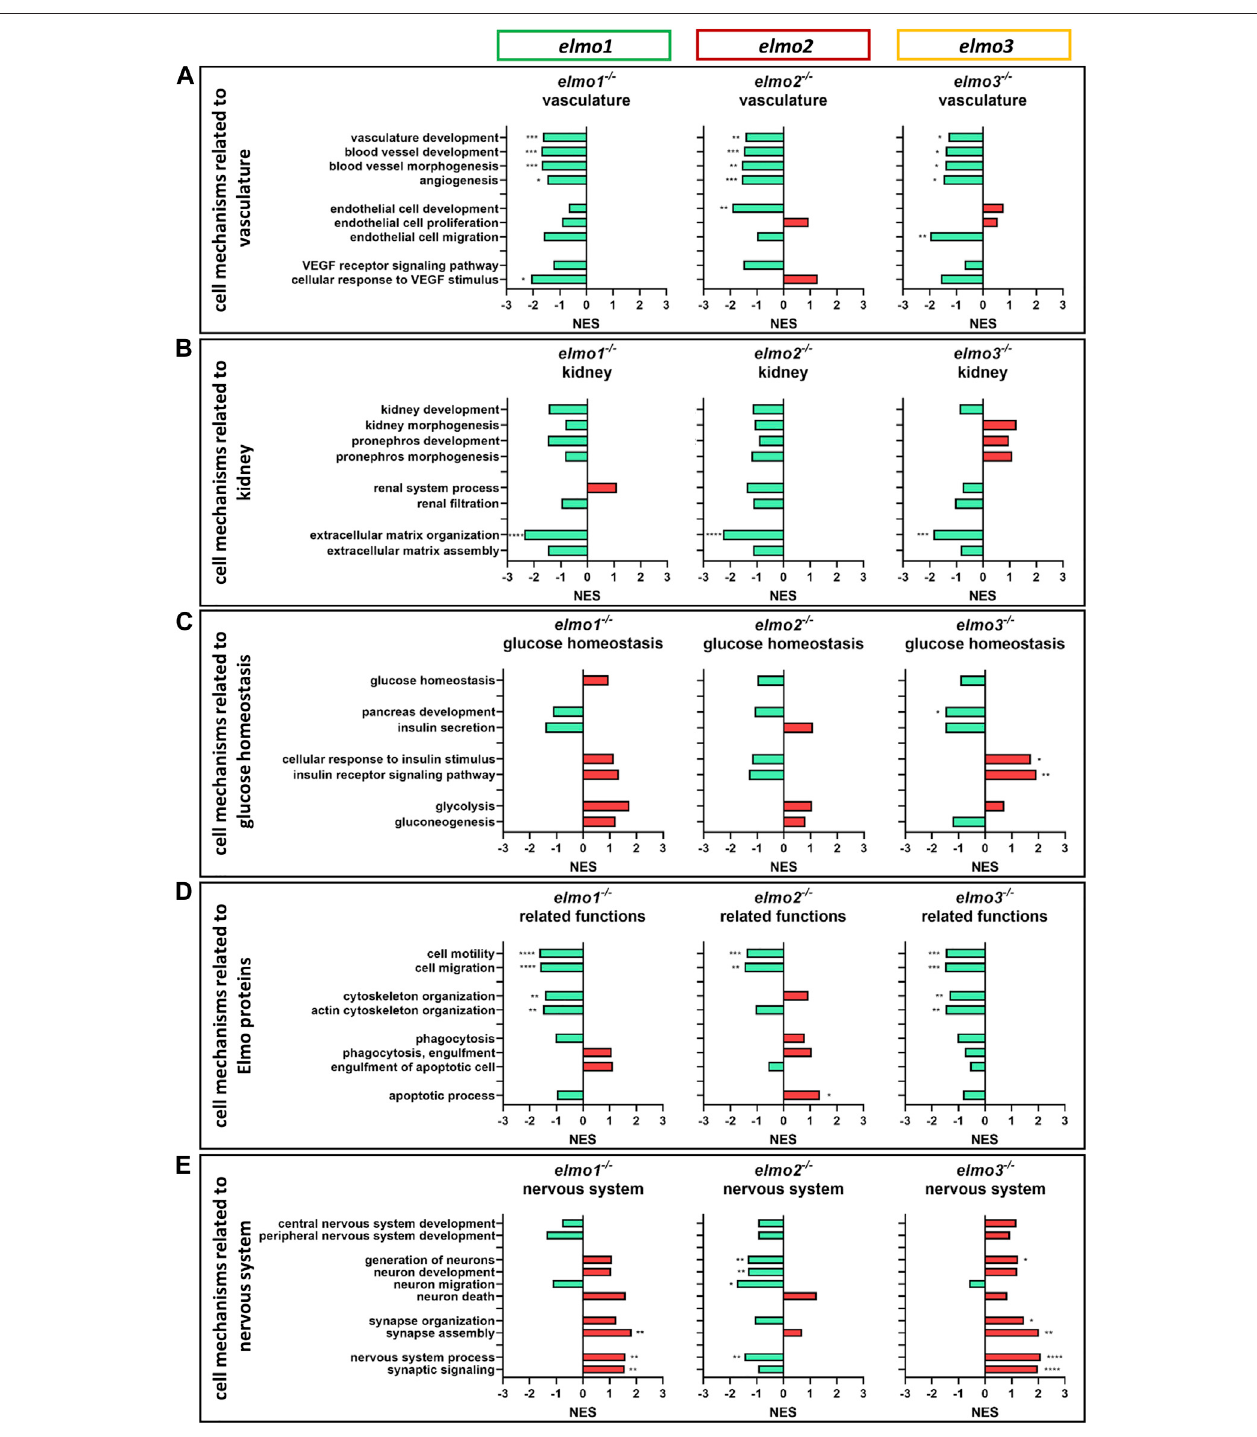
FIGURE 7 | The loss of Elmo1, Elmo2 and Elmo3 led to similar and different changes in the regulation of the transcriptome in larval zebra fi sh. Comparison of the regulation of cell mechanisms in elmo1 − / − , elmo2 − / − and elmo3 − / − zebra fi sh larvae, respectively, compared to elmo1 +/+ , elmo2 +/+ and elmo3 +/+ . Gene Ontology Biological Process (GOBP) based analysis of cell mechanisms of the transcriptome using RNA-sequencing data from zebra fi sh larvae at 120 hpf. n = 6 samples per genotype, each containing30zebra fi shlarvae.Regulation ofthegene sets isgivenasnormalizedenrichmentscore (NES). (A) Cell mechanisms related tovascular development were generally downregulated in elmo1 − / − , elmo2 − / − and elmo3 − / − . (B) Cell mechanisms related to kidney development and function showed a downregulationofextracellularmatrixorganizationin elmo1 − / − , elmo2 − / − and elmo3 − / − . (C) Cellmechanismsrelatedtoglucosehomeostasisweredifferentlyregulatedin elmo3 − / − . (D) Cell mechanisms related to further functions of Elmo proteins showed a general downregulation in elmo1 − / − and elmo3 − / − and different changes in elmo2 − / − . (E) Cell mechanisms related to the nervous system were generally upregulated in elmo1 − / − and elmo3 − / − and downregulated in elmo2 − / − . hpf, hours post fertilization; NES, normalized enrichment score.